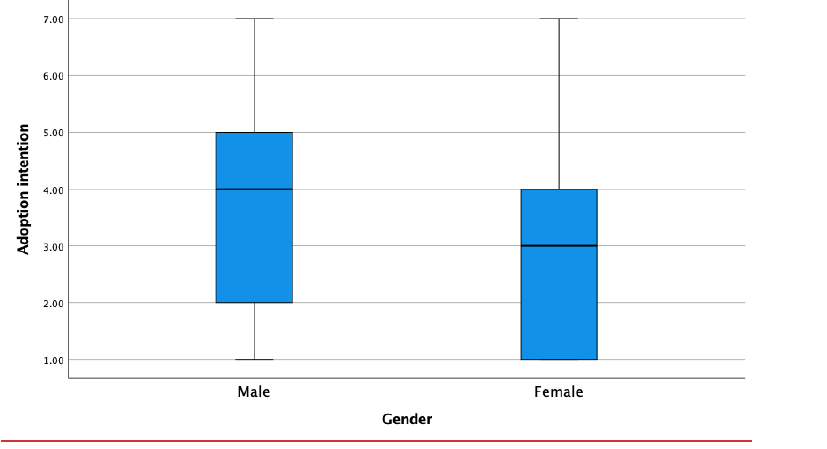
Fig. 10. Adoption intention by gender